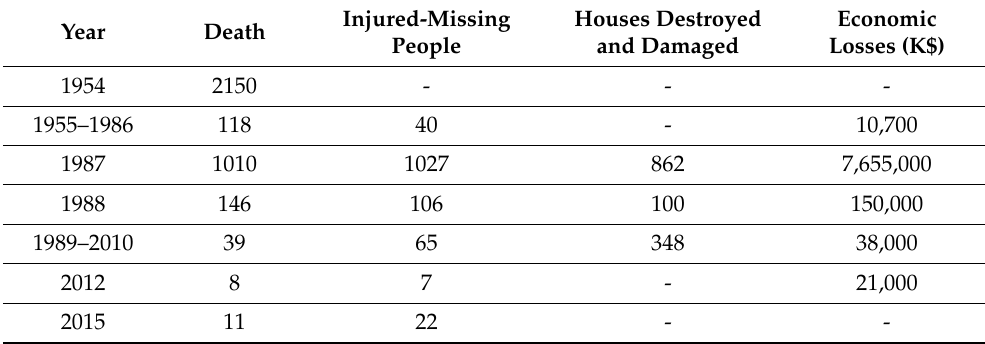
Table 1. Summary of the floods that occurred in Tehran (Adapted with permission from [17]).